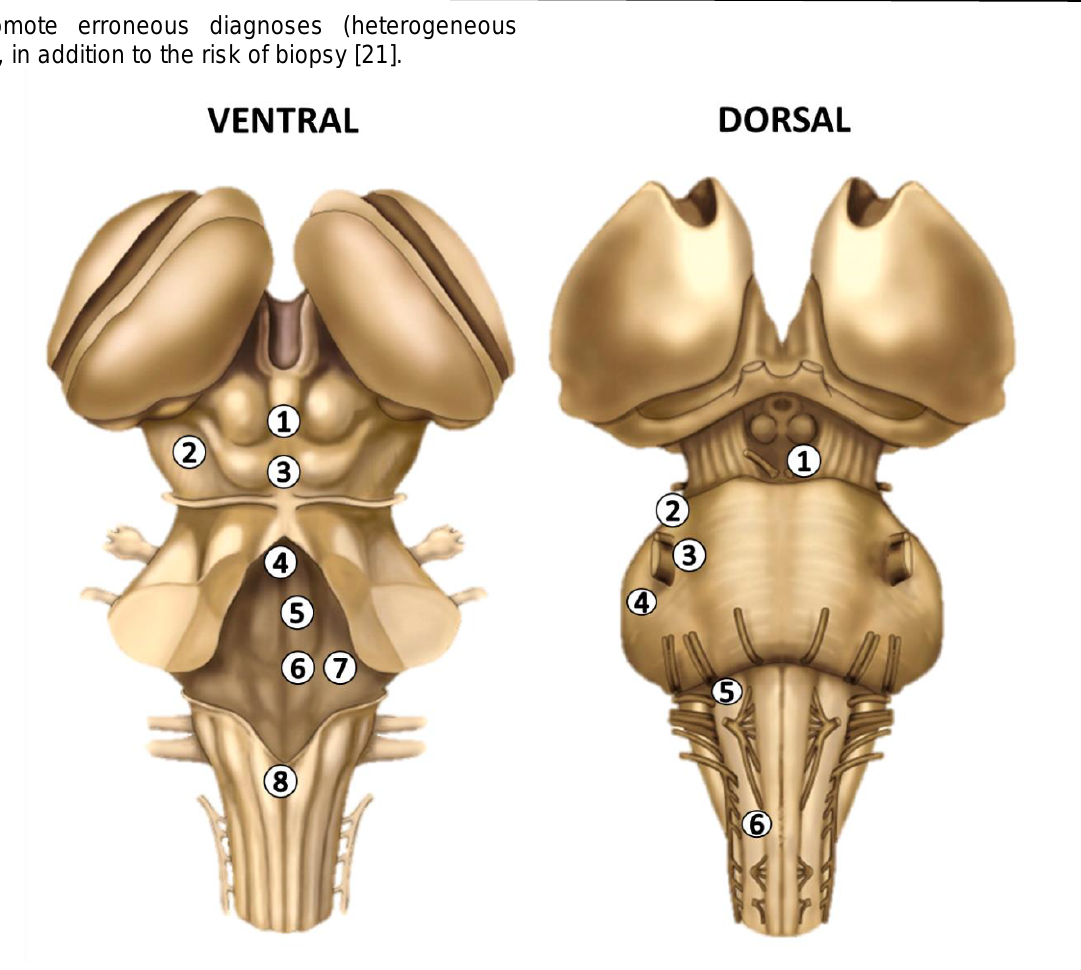
Figure 7 - “Safe” entry zones for surgical access to the brainstem. VENTRAL: 1 - Supracollicular zone. 2- Lateral mesencephalic sulcus. 3 - Infracolicular zone. 4 - Median sulcus of 4th ventricle. 5 - Supracollicular paramedian . 6 - Infracollicular paramedian. 7 - Acoustic area. 8 - Dorsal sulcus of the medulla. DORSAL: 1 - Anterior mesencephalic zone. 2 - Supratrigeminal zone. 3 - Peritrigeminal zone. 4 - Side pons area. 5 - Olivary zone.6 - Anterolateral